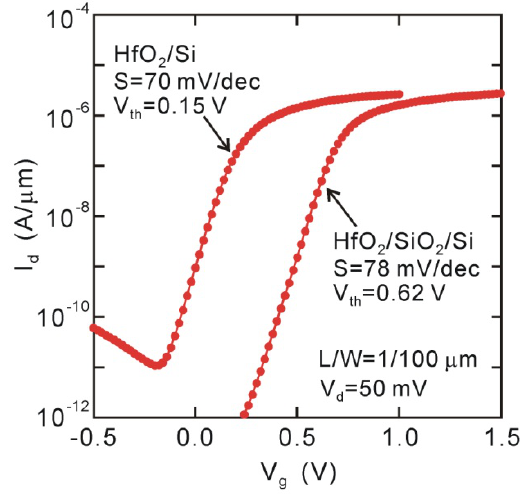
/Si and HfO 2 /Si 2